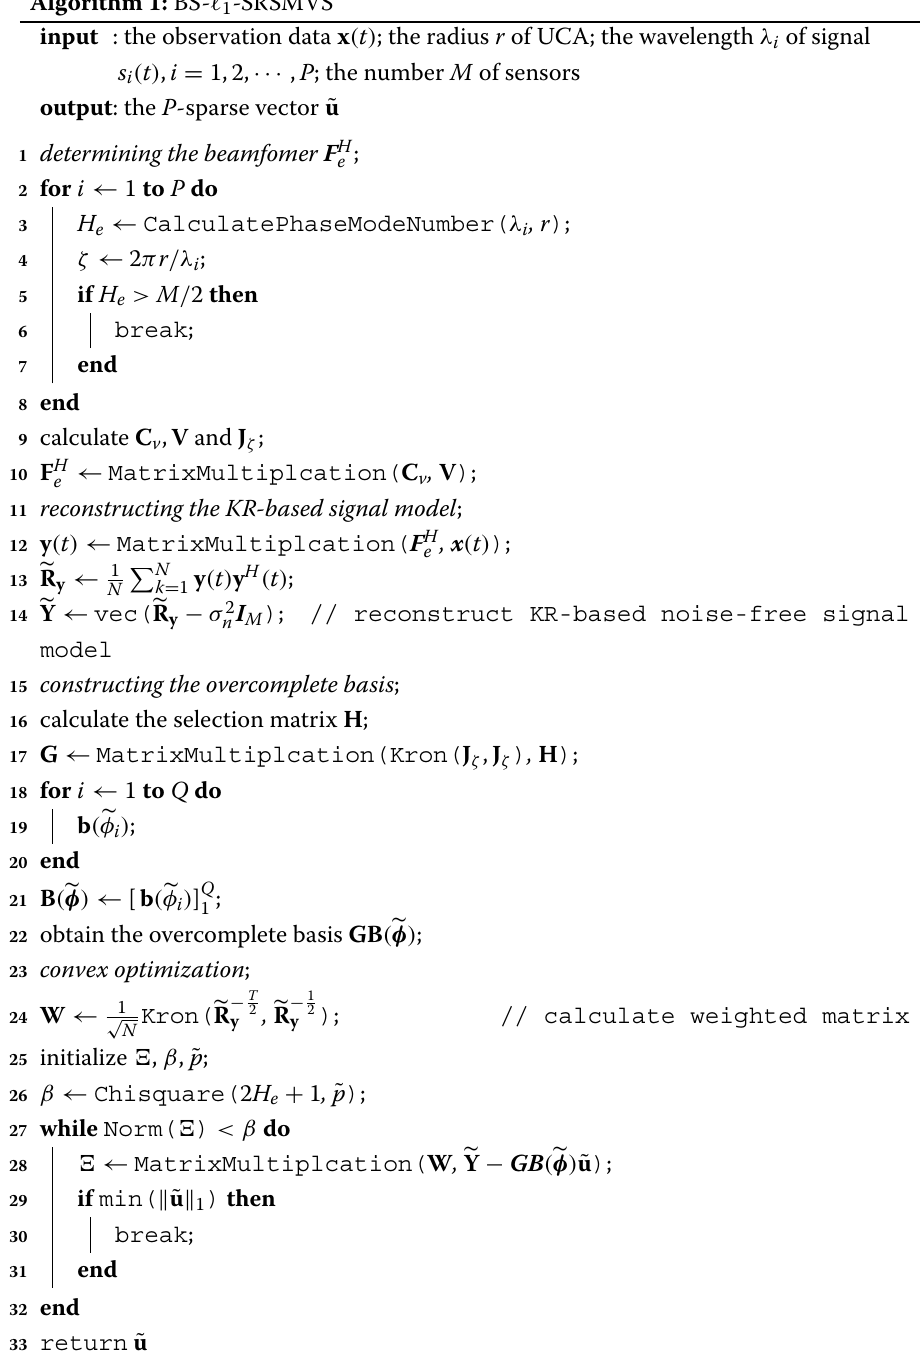
Algorithm 1: BS- (cid:2) 1